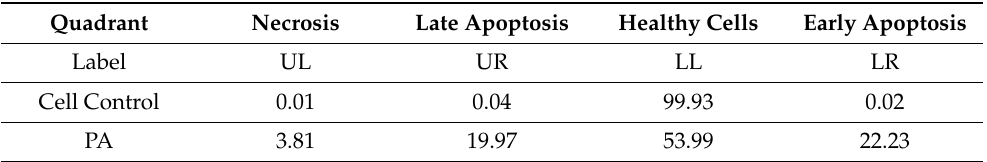
Figure 13. Flow cytometric analysis of P. alba AgNPs against U118 MG cancer cell line. Quadrangular plot of Annexin V/PI expression on U118 MG cells ( A ) Untreated cells, ( B ) AgNP-treated cells. Cell cycle of U118 cell line ( C ) Untreated, ( D ) AgNP-treated. Scatter plot of forward scatter (FSC) against side scatter (SSC) ( E ) Untreated cells, ( F ) AgNP-treated cells. Table 1. Table showing the % of cells of that underwent apoptosis and necrosis in untreated and test (PA) treated U118 MG cells in comparison to viable